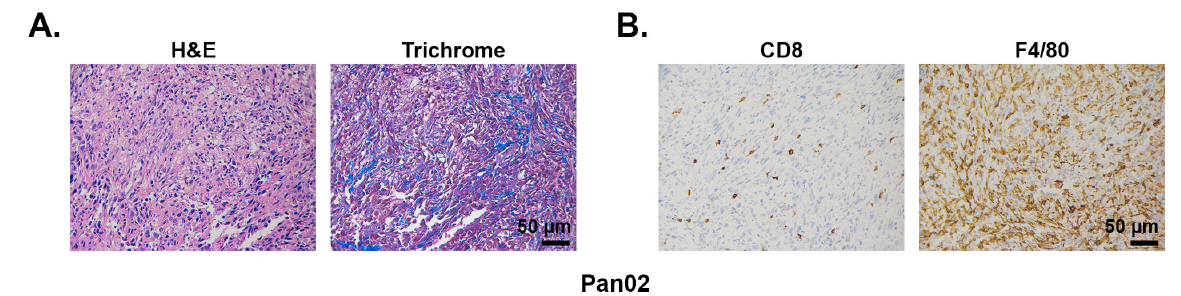
Figure 2. Desmoplasia, CD8 + T cells, and macrophage infiltration in mouse Pan02 tumors. Pan02 tumors developing subcutaneously in C57BL/6J mice were H&E and trichrome stained ( A ) or stained by immunohistochemistry for CD8 + T cells and the macrophage marker F4/80 ( B ). Antibodies used: CD8 + (Cell Signaling, #98941) and F4/80 (Cell Signaling, #70076). Magnification, 20×.